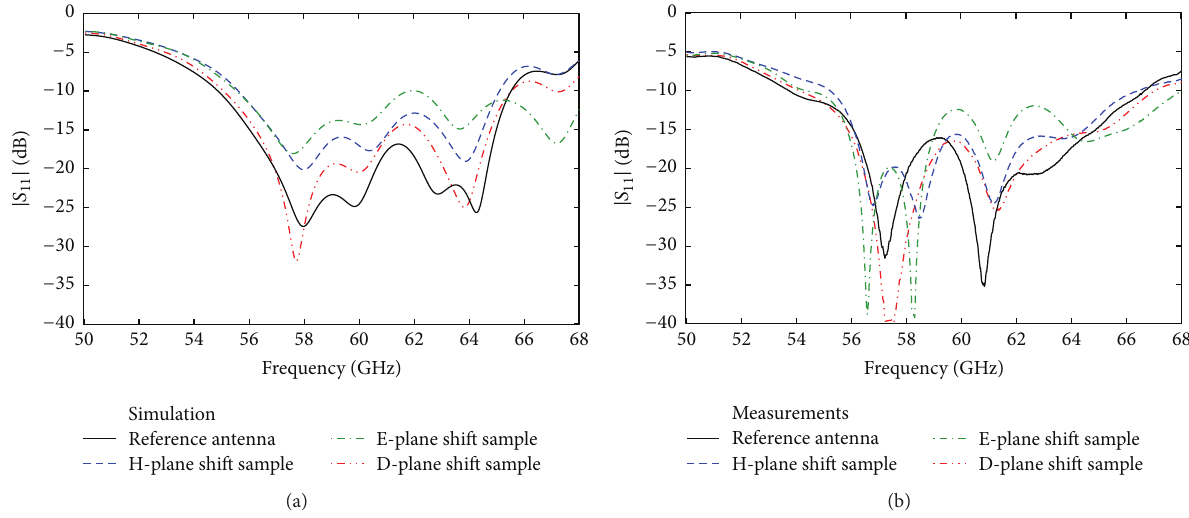
Figure 8: Simulated (a) and measured (b) reflection coefficient for the reference antenna (without shorting pins) and for samples with beam shift.